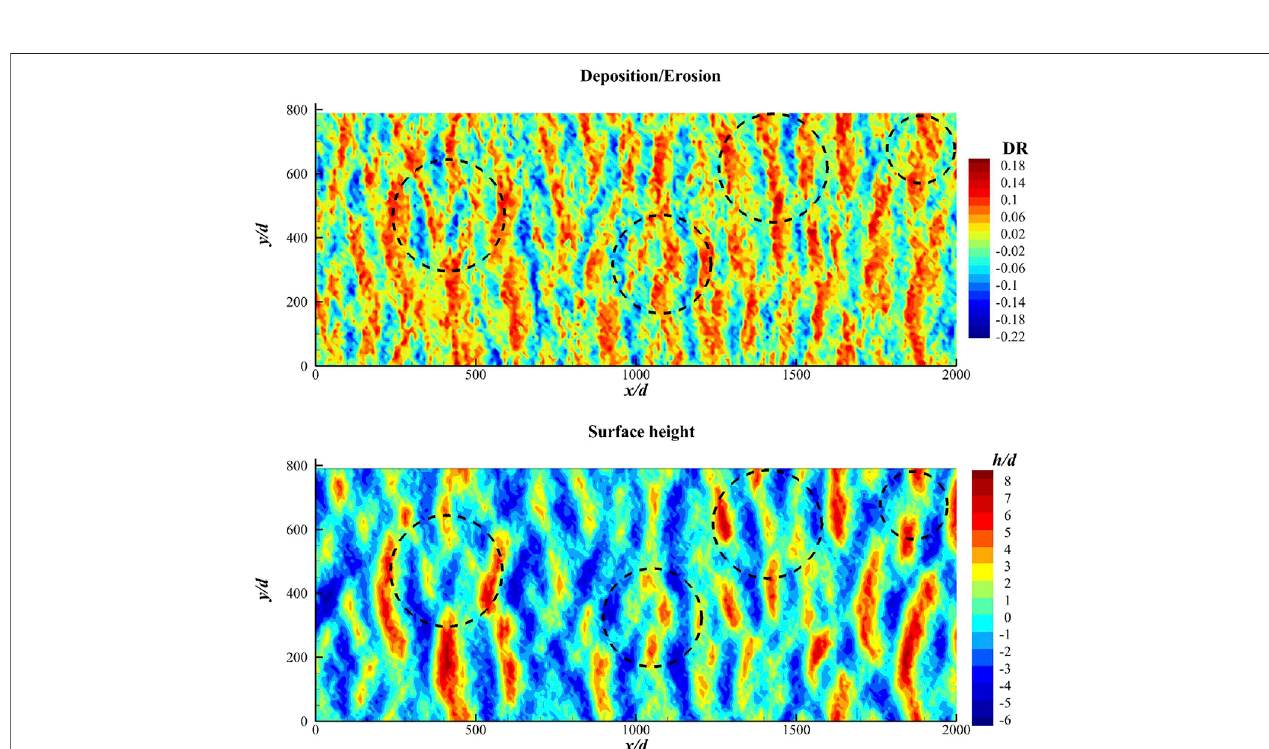
FIGURE 13 | Comparison between the deposition/erosion rate and the corresponding surface topology in the same area.